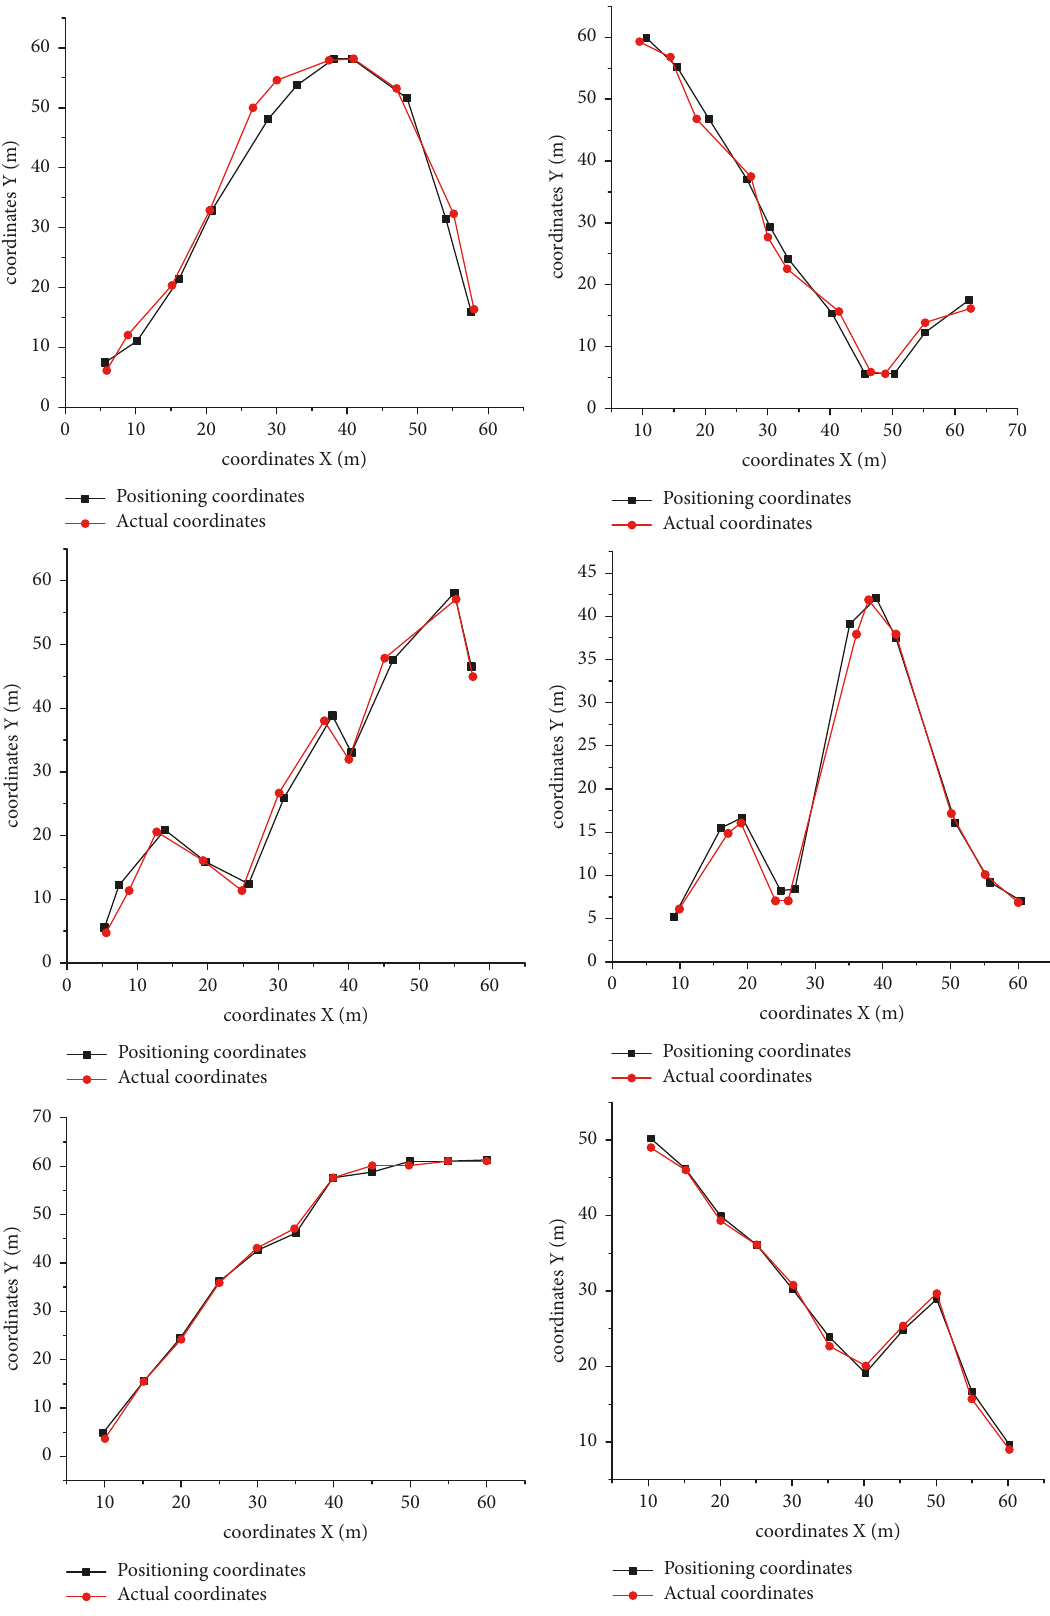
Figure 8: Location coordinates and actual